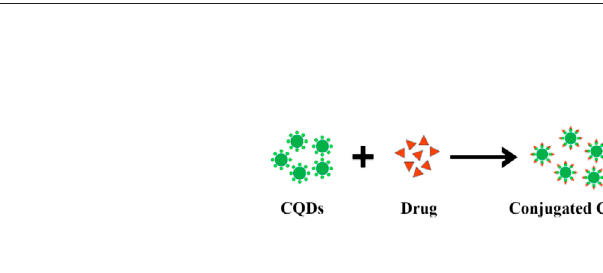
FIGURE 15 | Schematic representation of the CQD-guided drug delivery